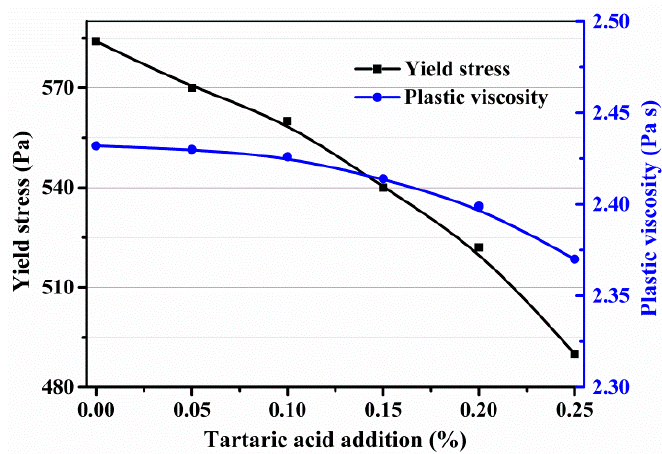
Figure 8. The plastic viscosity and yield stress of the fresh SAC paste with different additions of TA based on the Bingham model.